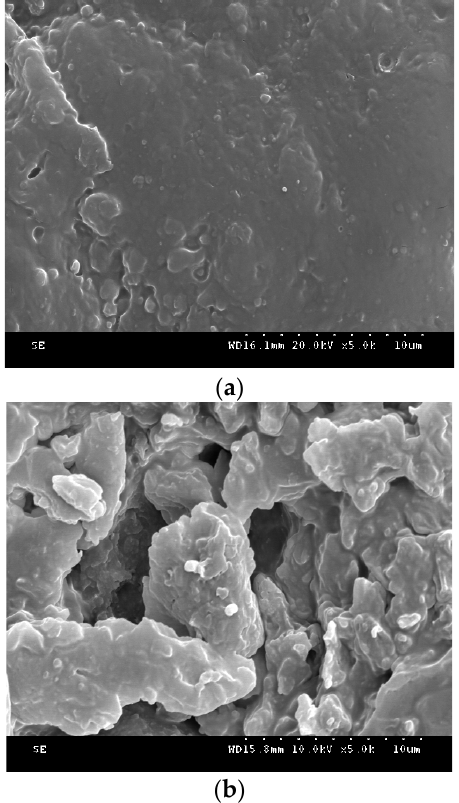
Figure 5. Scanning electron microscope images of the rapeseed meal (RSM) ( a ) and fermented rapeseed meal with acid protease (FRSMP) ( b ) (10 μ m) at 5000× magnification. The samples were photographed with secondary electron image at a low acceleration voltage of 5.0 kV.